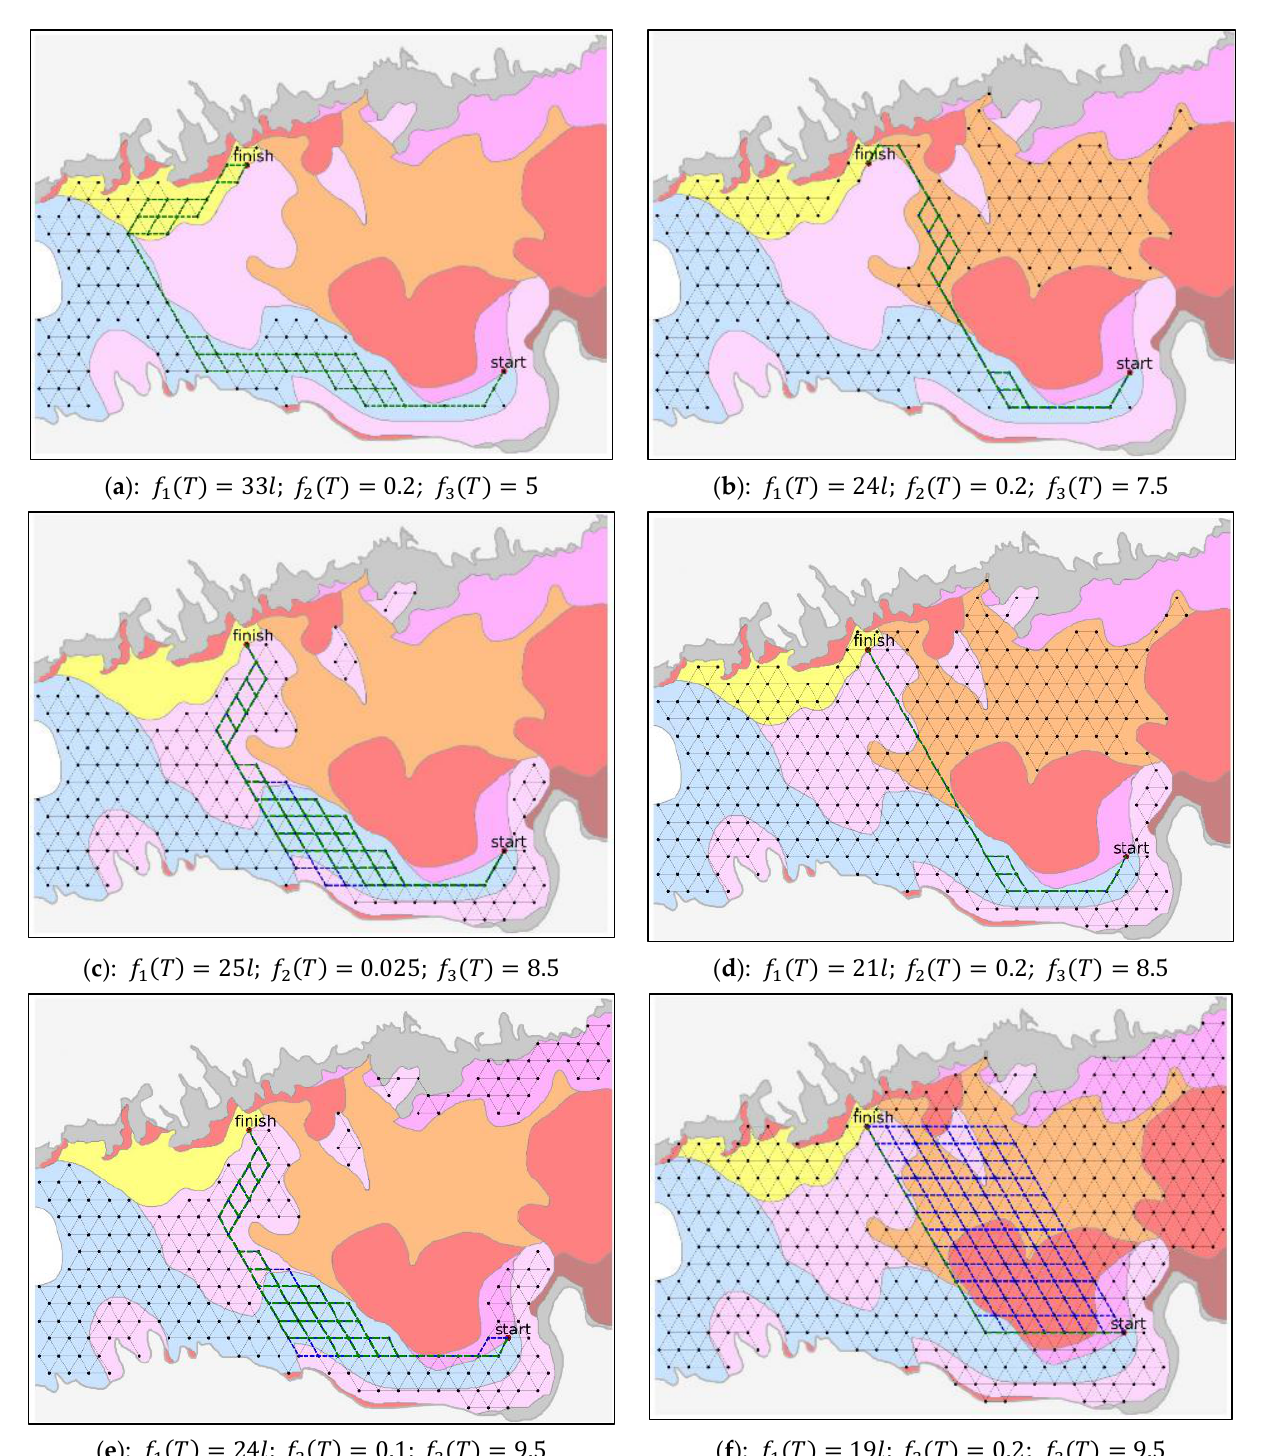
Figure 4. Graphical representation of all ℒ 𝑖 Pareto-optimal routes for the set of conditions given in Table 3 with respect to objective functions 𝑓 1 , 𝑓 2 , and 𝑓 3 . Characteristics of these routes are provided in Table 4. Optimal routes with respect to objective function 𝑓 4 (travel time) are given in green.